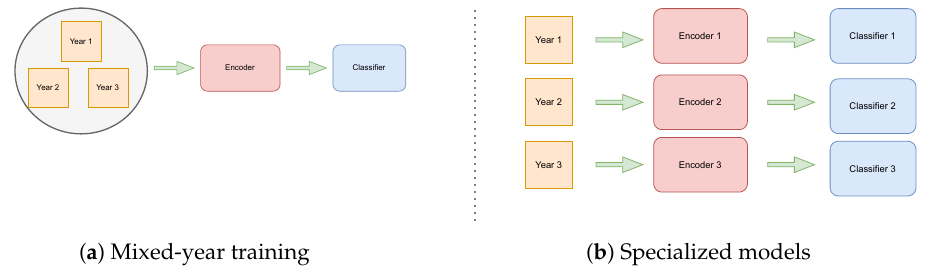
Figure 5. Training Protocol. A single model is trained with parcels taken from all three years ( a ), and three specialized models whose training set only comprises observation for a given year ( b ). Table 2. Quantitative evaluation. Performance (mIoU and OA) of the different specialized models M 2018 , M 2019 , M 2020 and of the mixed-years model M mixed evaluated on each year individually and all available years simultaneously with 5-fold cross-validation. The best performances are shown in bold. Boxed values correspond to evaluations where the training set and the evaluation set are drawn from the same year. The mixed-year model performs better for all years, even compared to specialized